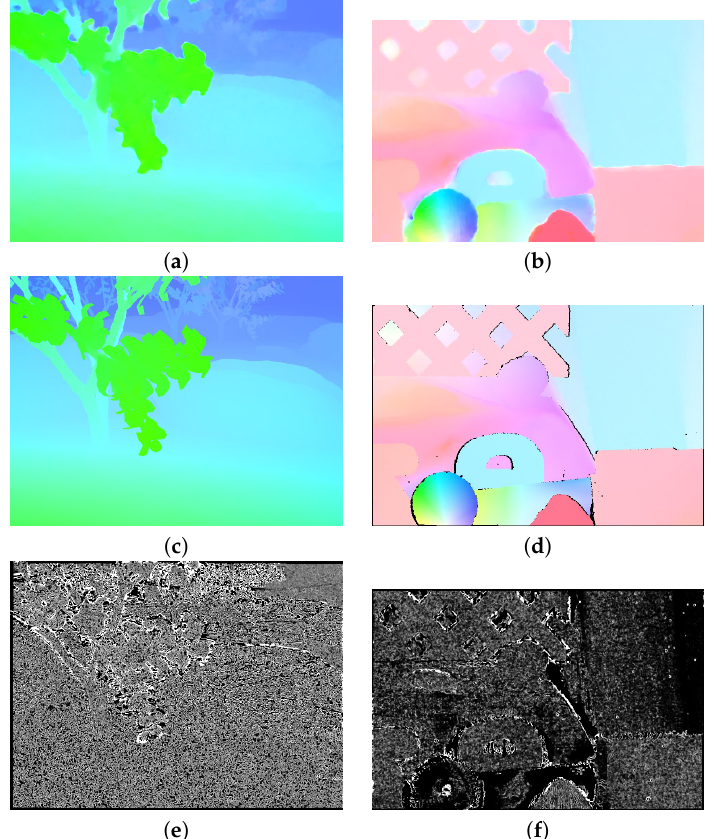
Figure 12. Color-coded optical flow. ( a ) Color-coded coded optical flow for Grove2. ( b ) Color-coded optical flow for RubberWhale. ( c ) Ground truth for the Grove2 sequence. ( d ) Ground truth for the RubberWhale sequence. ( e ) Weight map α ( x ) for Grove2. ( f ) Weight map α ( x ) for